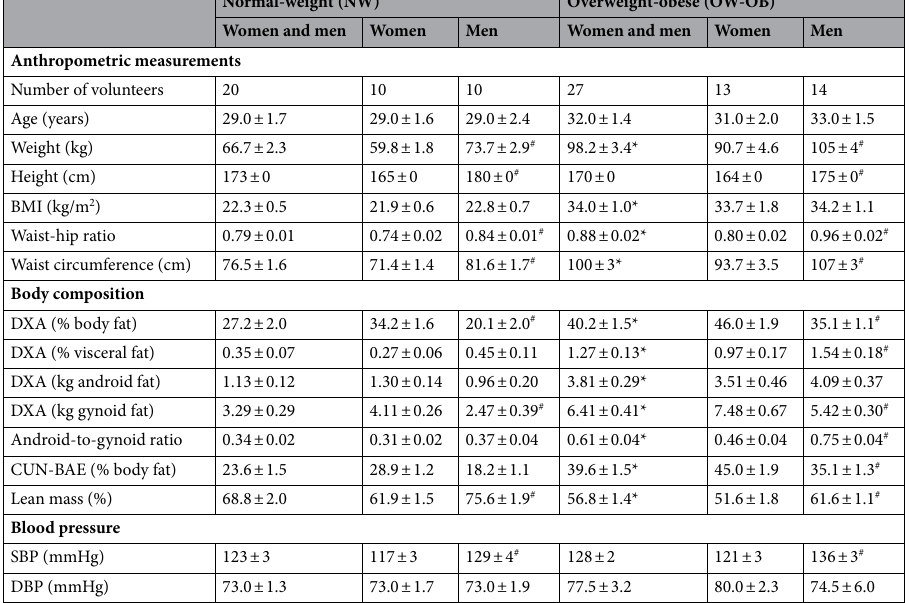
Table 1. Anthropometric measurements, body composition, and blood pressure in the NW and OW-OB groups. Data in each group (NW and OW-OB) is analysed considering all the individuals (women and men together), and stratified by sex. Data are mean ± SEM (n = 20 in the NW and n = 27 in the OW-OB group). Statistics: * OW-OB vs NW, and # NW men vs NW woman and OW-OB men vs OW-OB woman, p < 0.05, Student’s t